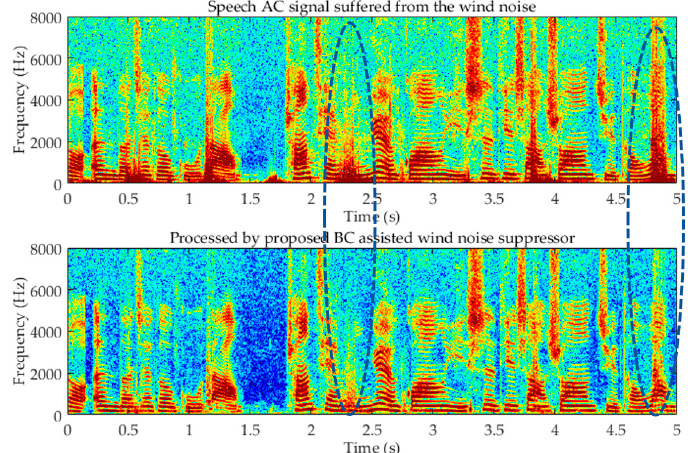
Figure 9. Wind noise processed by the proposed dual-microphone BC sensor-assisted method.